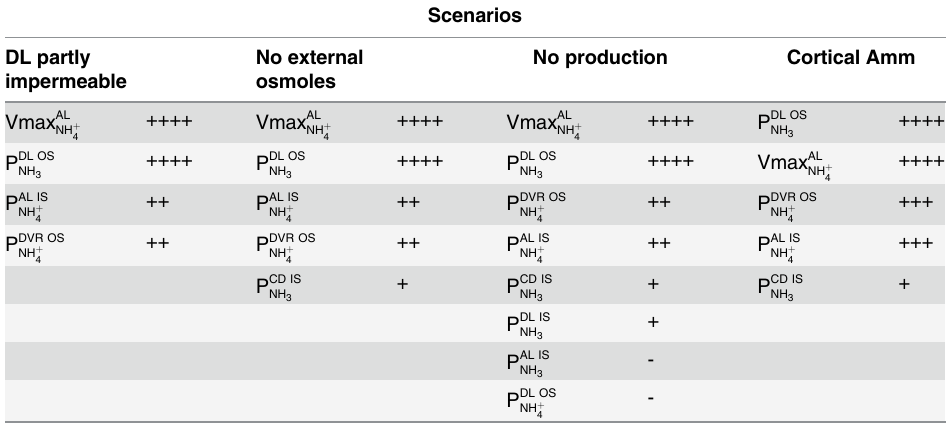
Table 3. Parameter analyses based on three alternative baseline